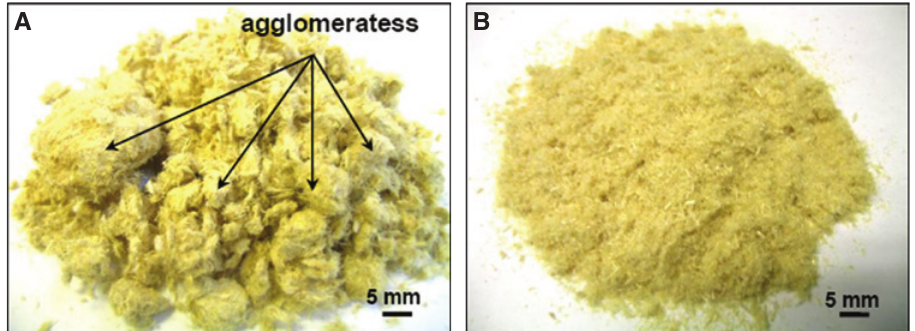
Figure 1 Photos for triticale (A) obtained from refining wet process and (B) after